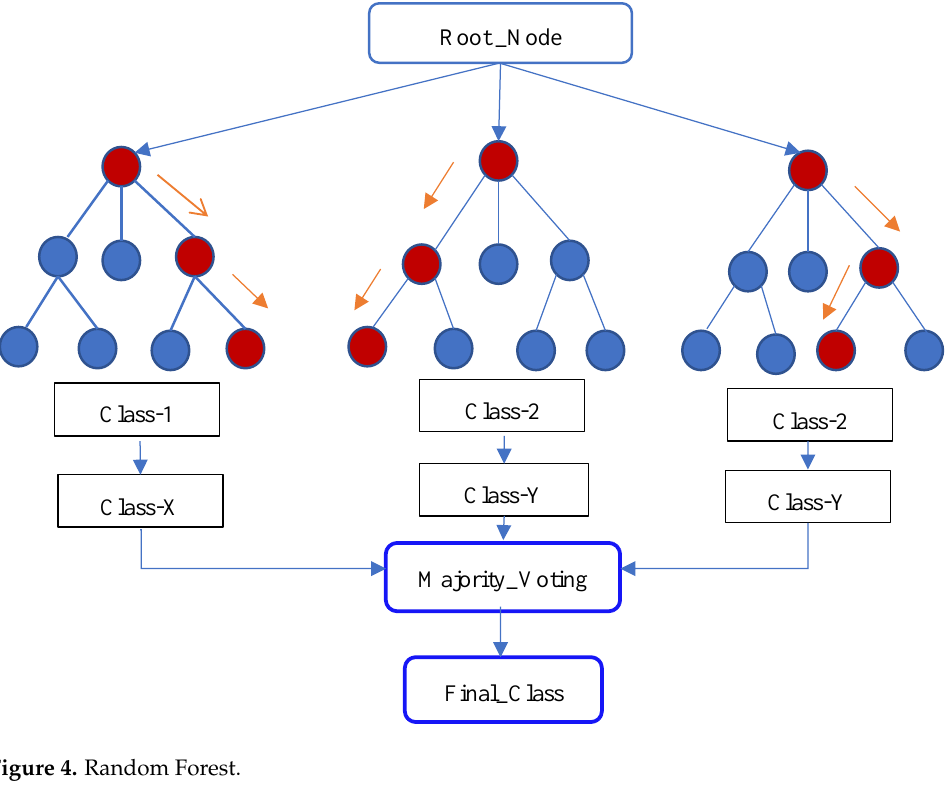
Figure 4. Random Forest.